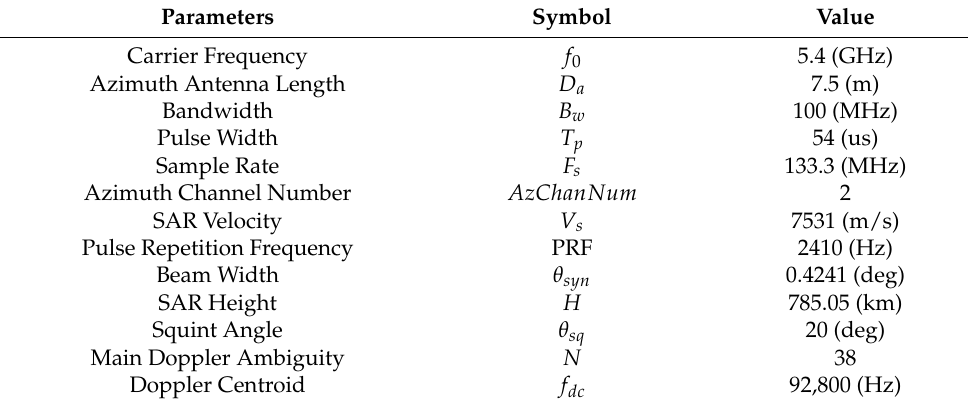
Table 1. The description of the simulation parameters.